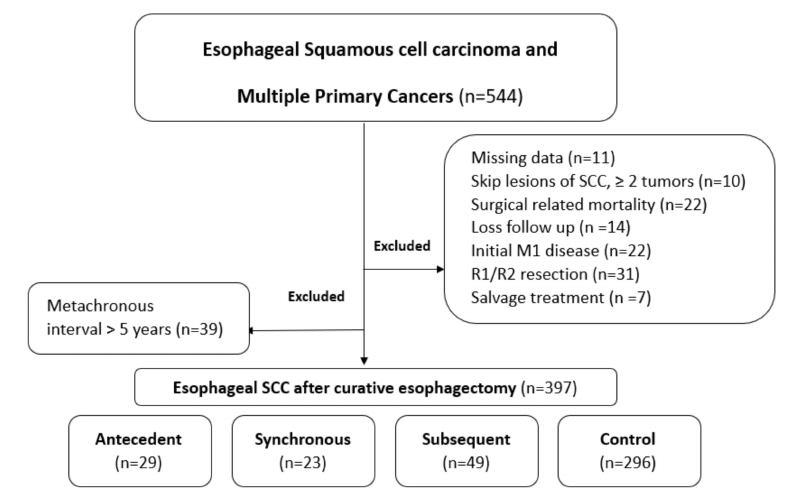
Figure 1. Summary of patient